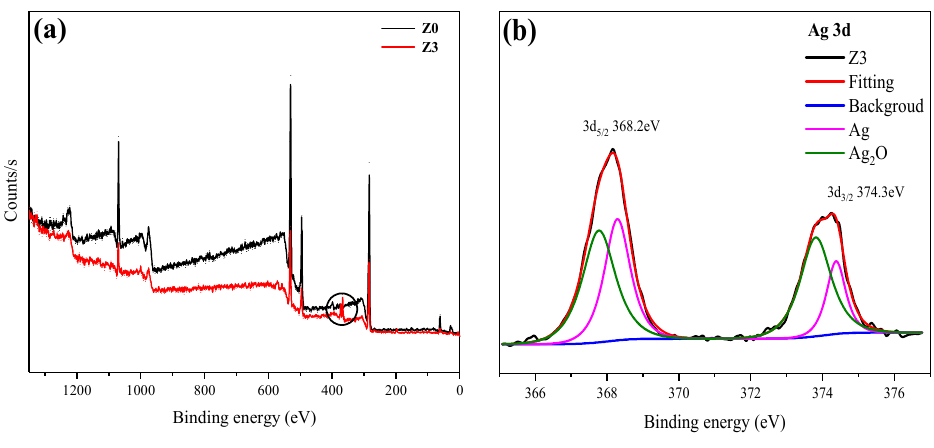
Figure 5. ( a ) XPS wide region scan spectra of the Z0 and Z3. ( b ) High resolution XPS Ag 3D spectrum of Z3.